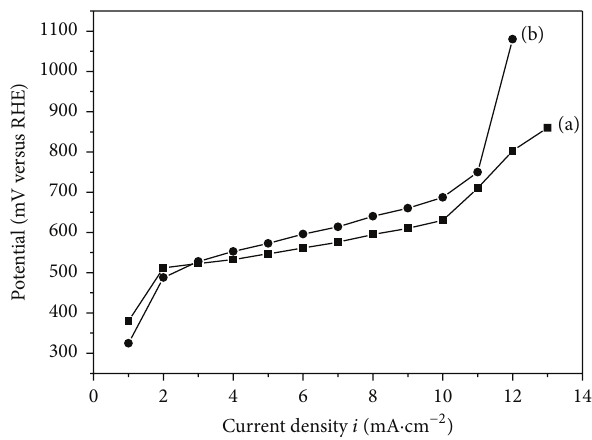
Figure 3: The polarization curves of sulfur dioxide reduction in an aqueous electrolyte: 10g ⋅ L −1 H 2 SO 3 ; 1M NaOH; 18g ⋅ L −1 NaCl; (a) stainless steel; (b) TV35 and DG + 20% CoPc; (c) LSNV; (d) TV35 and DG + 20% CoPc + 6% Pt; 𝑡 ∘ = 25 ∘ C.